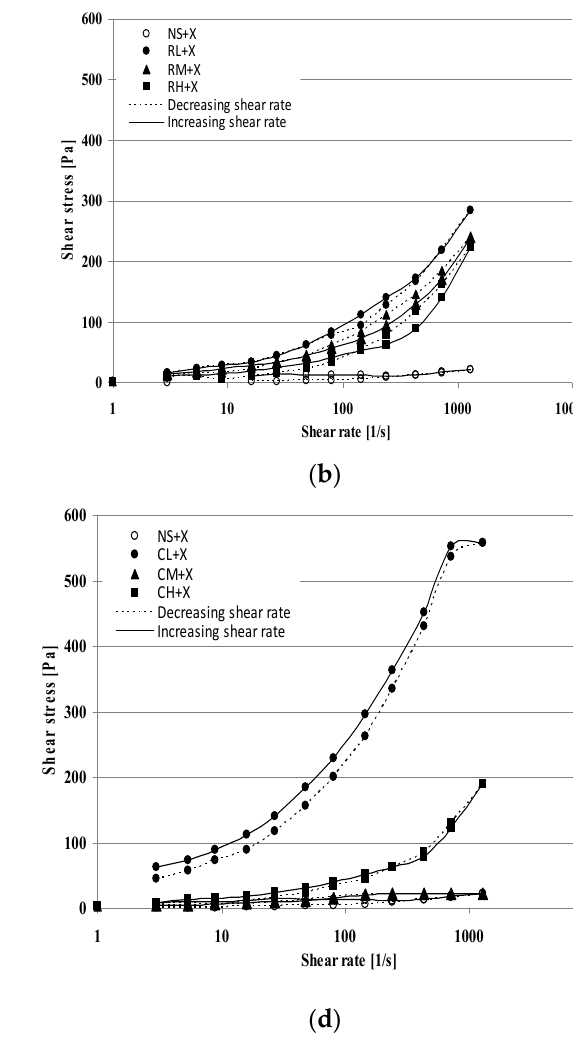
Figure 3. Thixotropy of blackberry jelly-like desserts obtained from modified corn starches sweetened with sucrose ( a,c ) or xylitol ( b,d ).